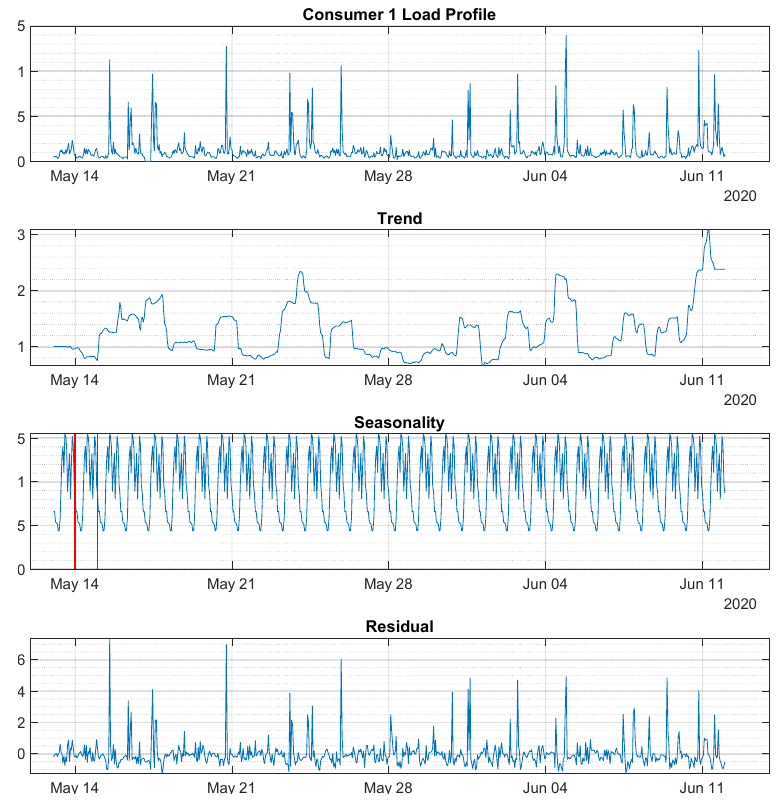
Figure 2. Example of the TSR decomposition on a section of the dataset, 30 days of the Consumer 1 Load Profile decomposed in Trend, Seasonality and Residual. A sweet spot for the dataset is found at multiples of 24 and 48 h, as shown in Figure 3. This is expected both due to the natural periodicity of the produced power from the PV devices, and to the anthropic nature of the load